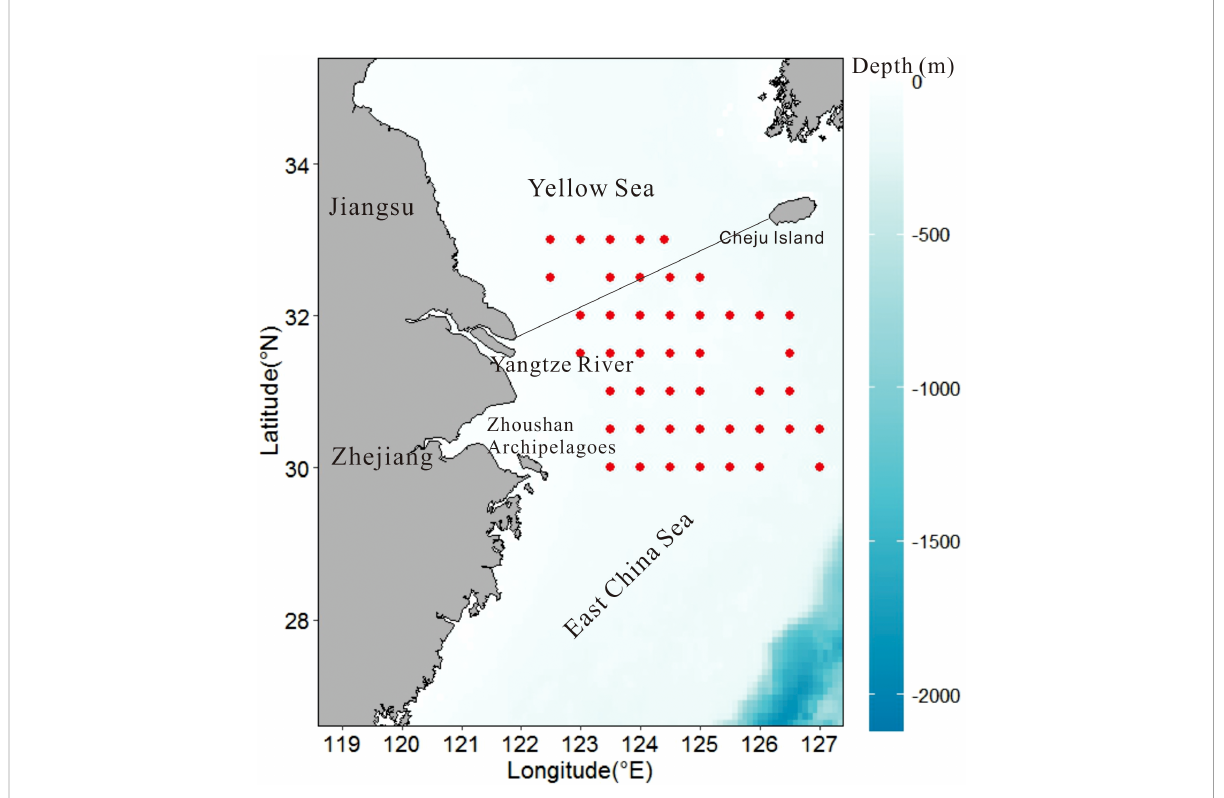
FIGURE 1 Sample locations for demersal trawl surveys for fi sh stocks in the northern East China Sea. Color bar indicates water